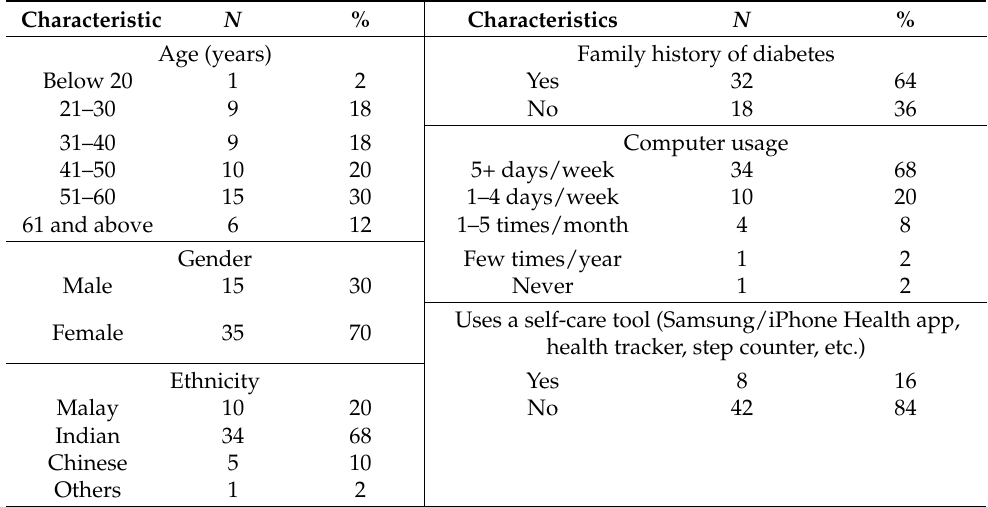
Table 4. Demographic characteristics of the study participants.